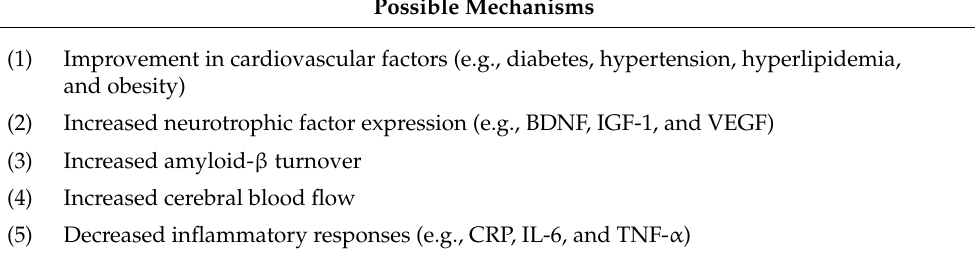
Table 2. Possible mechanisms of the effects of physical activity and exercise interventions on cognitive decline and dementia